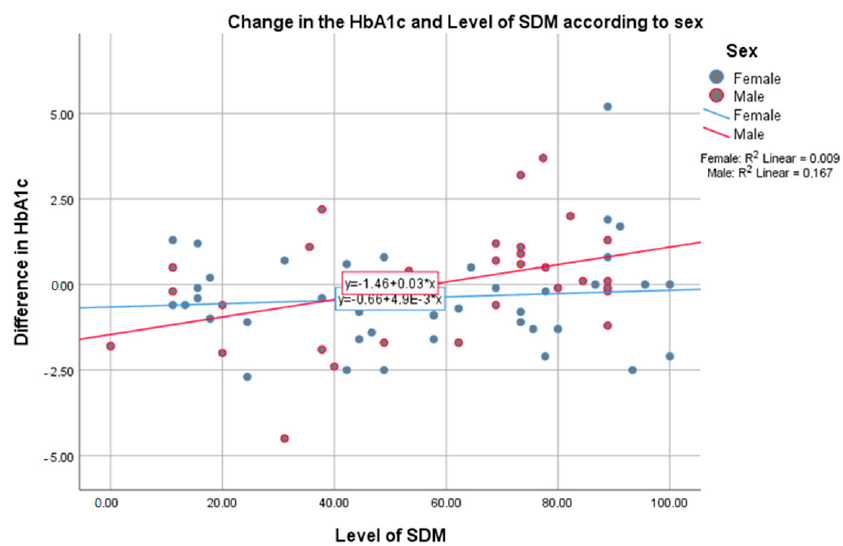
Figure 2. Change in the HBA1c and Level of SDM According to Sex. Scatter-plot assessing the regression models explaining the change in HbA1c with the level of SDM according to the sex. For males, the regression model significantly explained 16.7% of the variance ( p = 0.02). On the other hand, for females, the regression model was not statistically significant ( p = 0.53) and it explained only 0.9% of the variance.